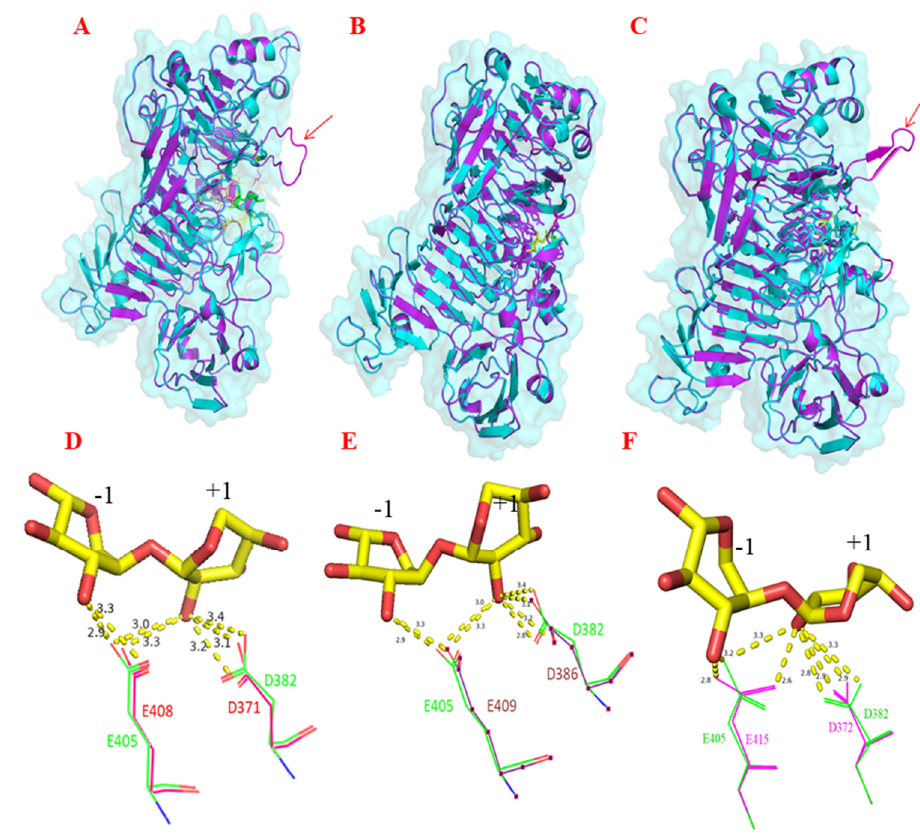
Figure 6. Homology modelling of Bp-XylX-1, Bp-XylX-2, and Lr-XylC β -xylosidases. Homology modelling of β -xylosidases from L. reuteri ATCC 53608 and B. producta ATCC 27340 was based on PDB ID: 3VSU of Ts-XOS using Phyre2. Bp-XylX-1 ( A ), Bp-XylX-2 ( B ), and Lr-XylC ( C ) are superimposed onto 3VSU (cyan). Catalytic nucleophile (Asp-D) and proton donor (Glu-E) were identified in Bp-XylX1 ( D ), Bp-XylX2 ( E ), and Lr-XylC ( F ) on the basis of 3VSU (green). Homology modelling was performed in PyMOL.